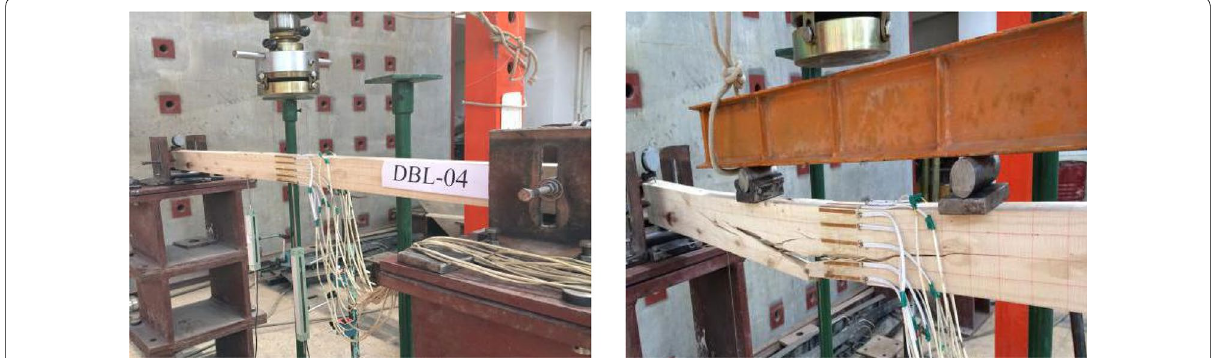
Fig. 6 Typical failure of the control timber